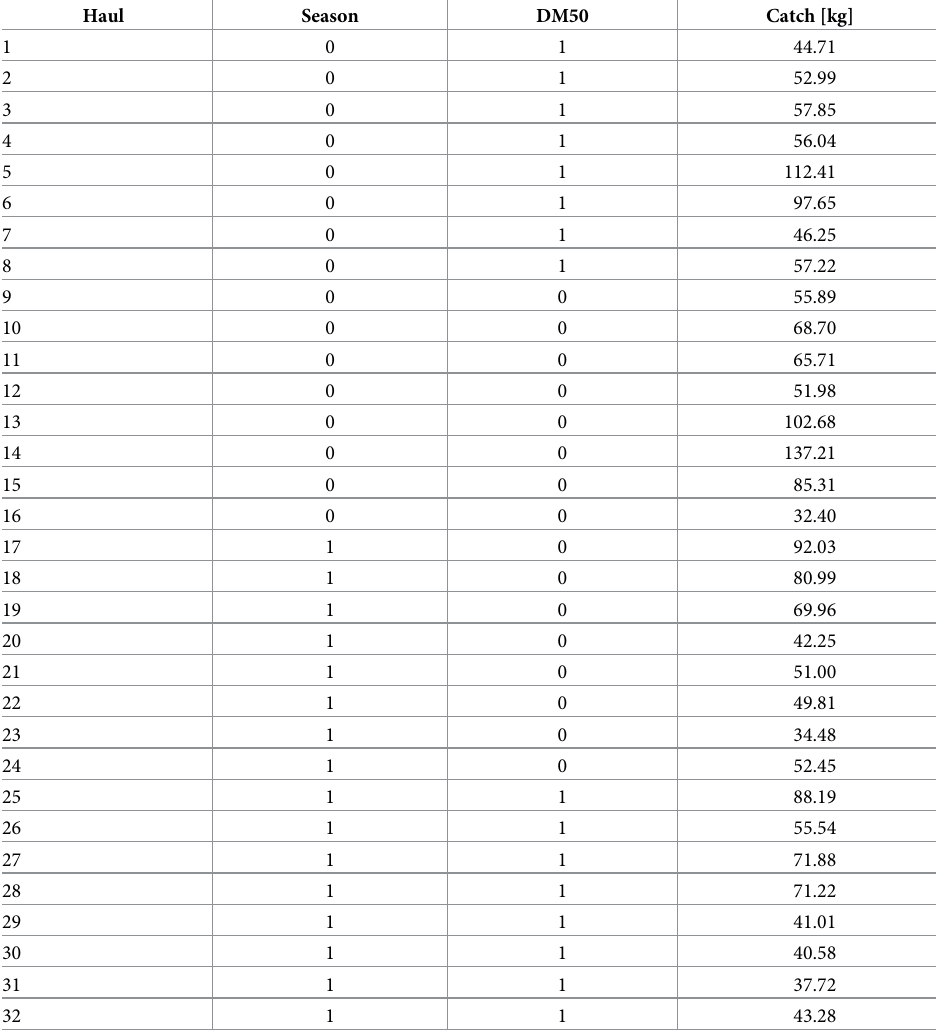
Table 1. Parameters used for